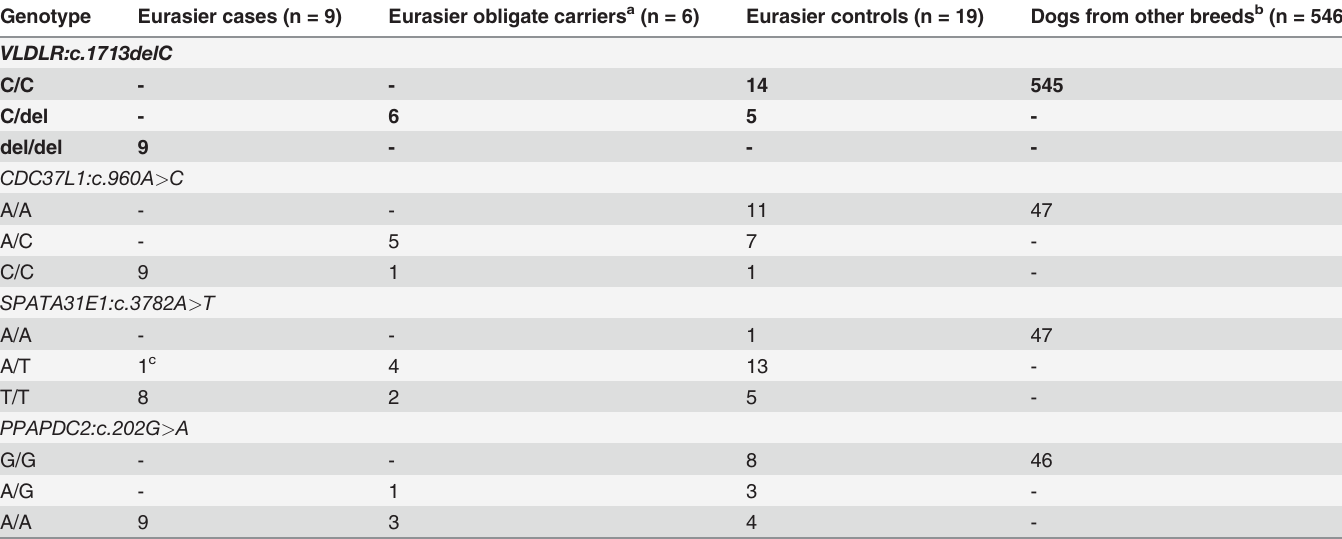
Table 3. Association of non-synonymous variants with DWLM.